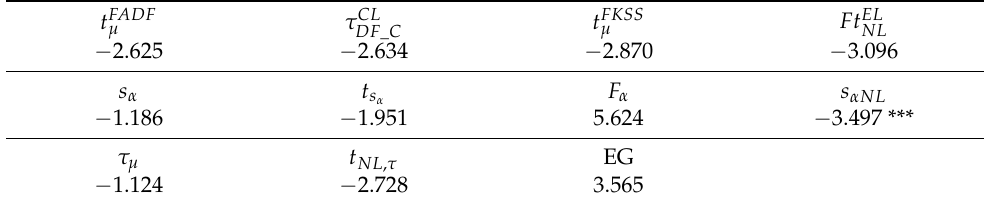
Table 8. Empirical application to the Turkey/US real exchange rate over 1990:1–2013:11.